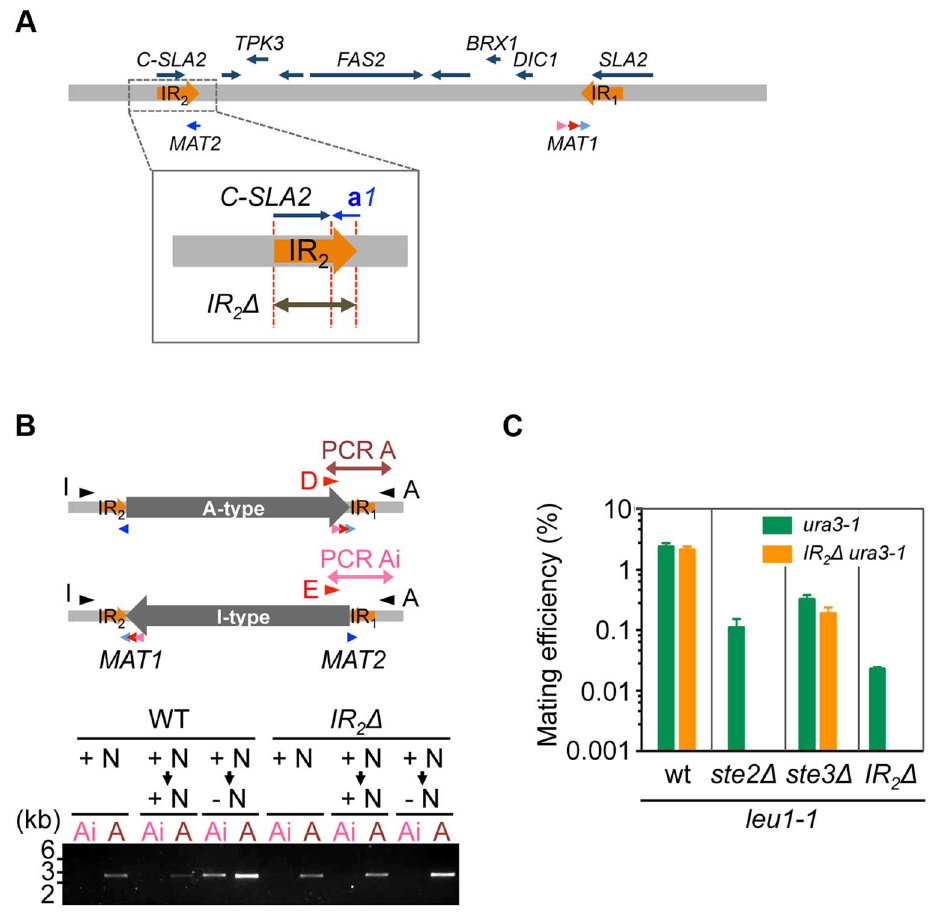
Figure 6. Inversion of the MAT intervening region is essential for homothallism. (A) Schematic of the strategy for IR 2 deletion on the A-type chromosome. (B) IR 2 D cells are defective for the inversion. Logarithmically growing wild-type (HPH22i) and IR 2 D (HPH833) cells in YPDS medium ( + N, nutrient plus) were transferred to YPDS ( + N R + N) or MEMA ( + N R 2 N, nutrient minus) and incubated for 20 h. Genomic DNA samples were prepared and inversion was detected by two PCR reactions, A and Ai, using the primer sets Primer_D/Primer_A and Primer_E/Primer_A, respectively. (C) Cells of the A-type strain carrying the IR 2 D allele are incapable of mating with each other and with ste2 D . Wild-type (HPH22 and SH4330), ste2 D (HPH553), ste3 D (HPH581), and IR 2 D (HPH833 and HPH835) cells were treated as described in Fig. 3A. Shown is the average of three independent matings. Error bars indicate